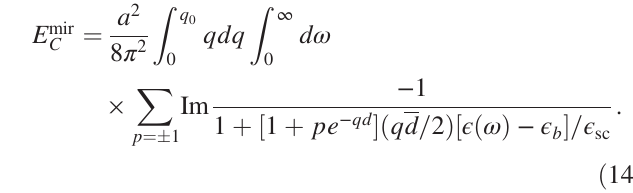
ð T Þ for Bi2212 with different carrier C